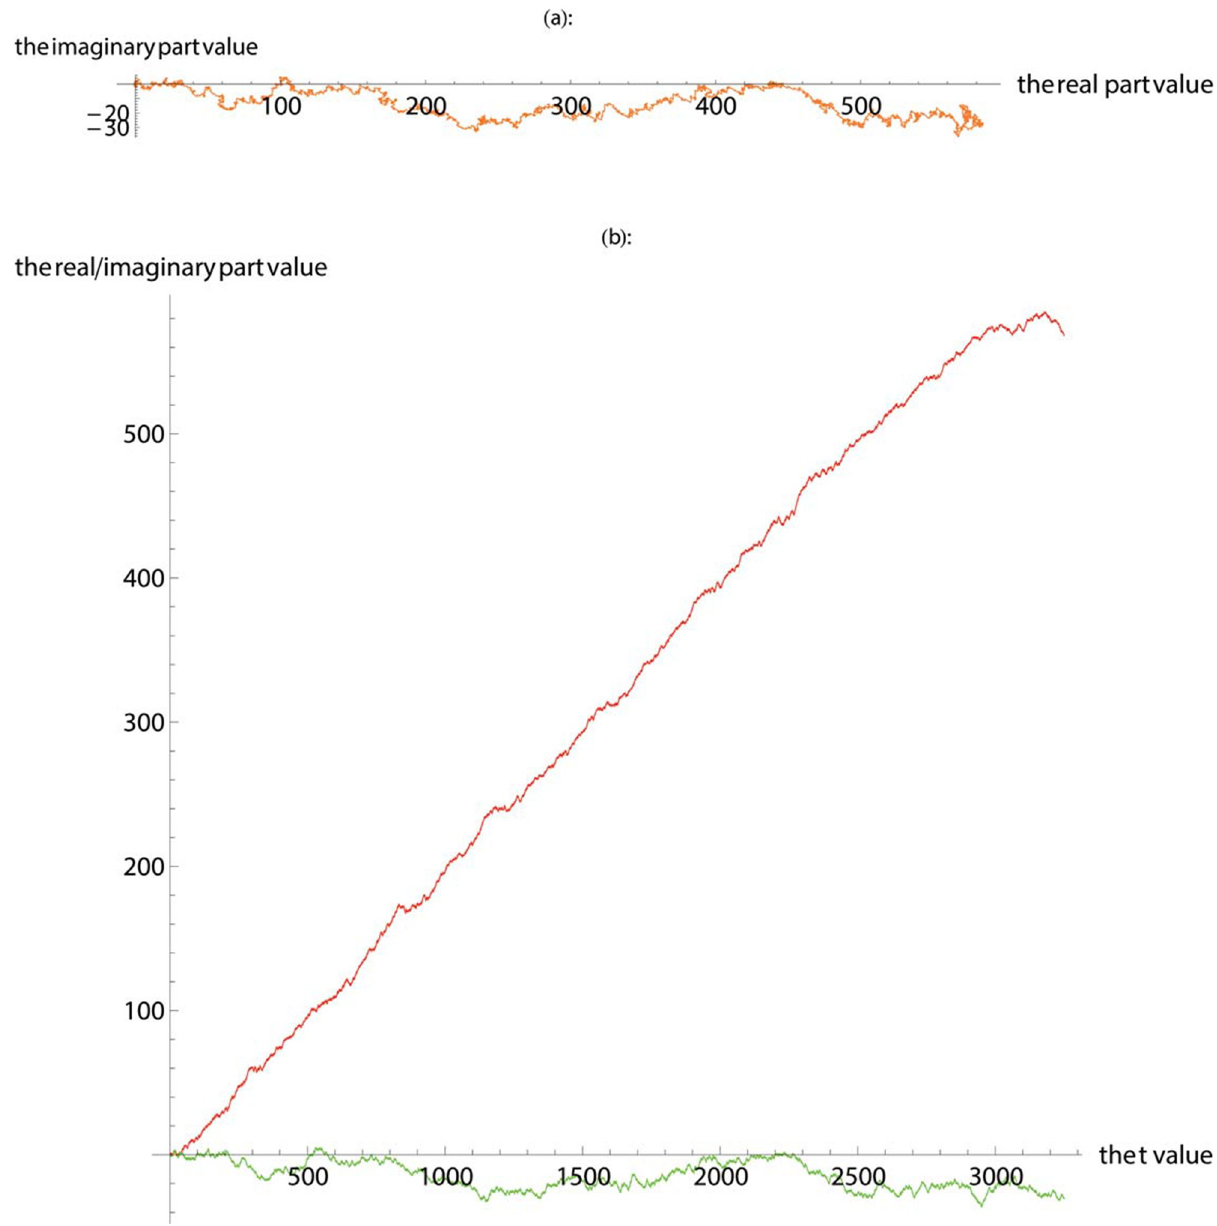
Fig 5. The TP walk of the suspected gene fragment 21-21000-24250. ( a ) Plot the walk trace in the complex plane. ( b ) Plot the real part (red) and imaginary part